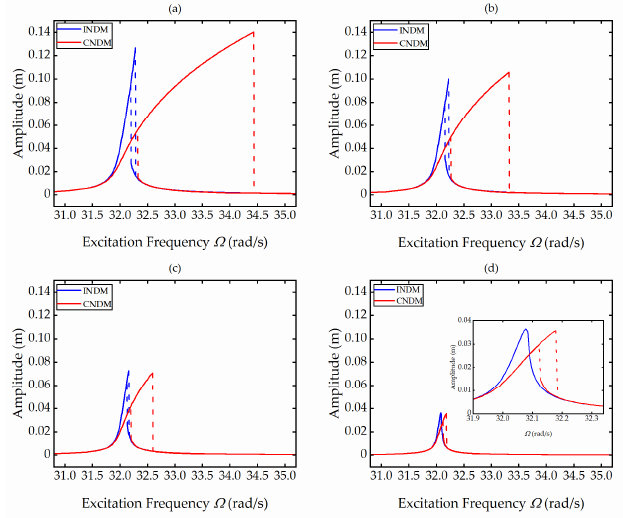
Figure 9. Frequency responses of the INDM and the CNDM at different excitation amplitudes: ( a ) w 0 = 0.0008 m; ( b ) w 0 = 0.0006 m; ( c ) w 0 = 0.0004 m; ( d ) w 0 = 0.0002 m.